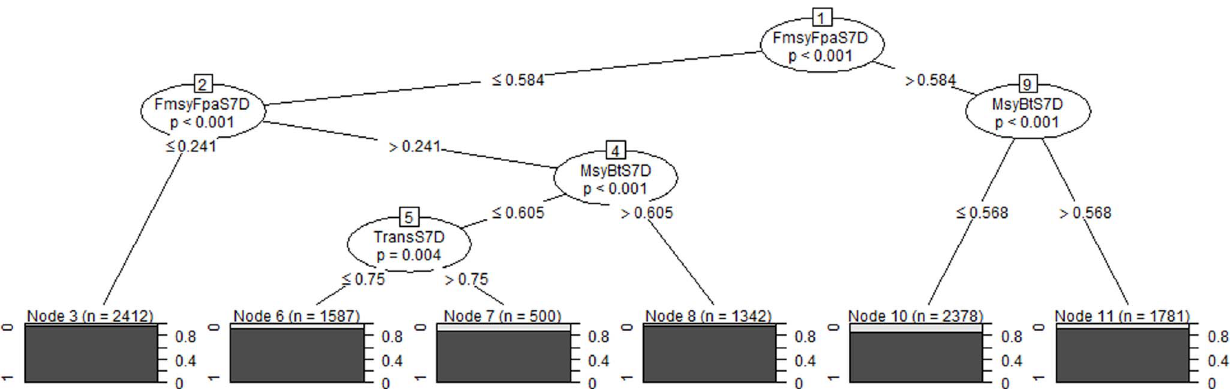
Figure 4. Main tree built on management measures for sole in subarea 7D. The criterion separating successes from failures is a 8000t spawning biomass threshold. Splitting variables (and values) are sorted by importance, from the top to the bottom of the tree (the most important corresponding to node 1). Values appearing on branches of the tree are the splitting values. The black and grey squares at the bottom of the tree are the terminal nodes or leaves.